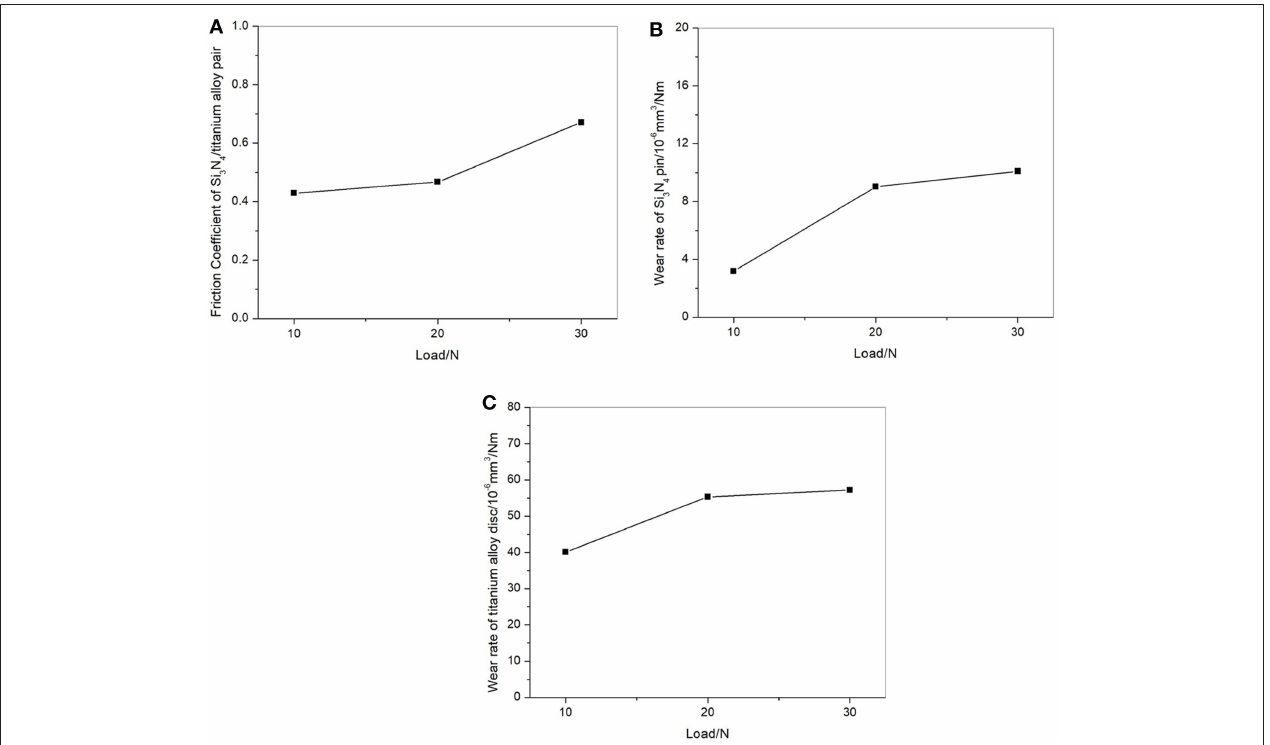
FIGURE 3 | Titanium alloy in sliding contact against Si 3 N 4 in seawater, (A) Friction coefficient, (B) wear rate of pin specimen, (C) wear rate of disc specimen.